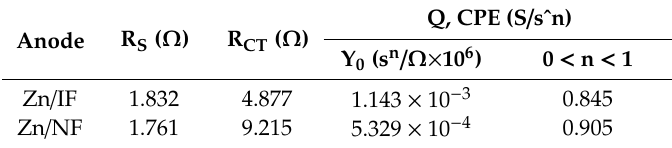
Table 1. Resistance values of Zn anodes in the solution electrolyte.